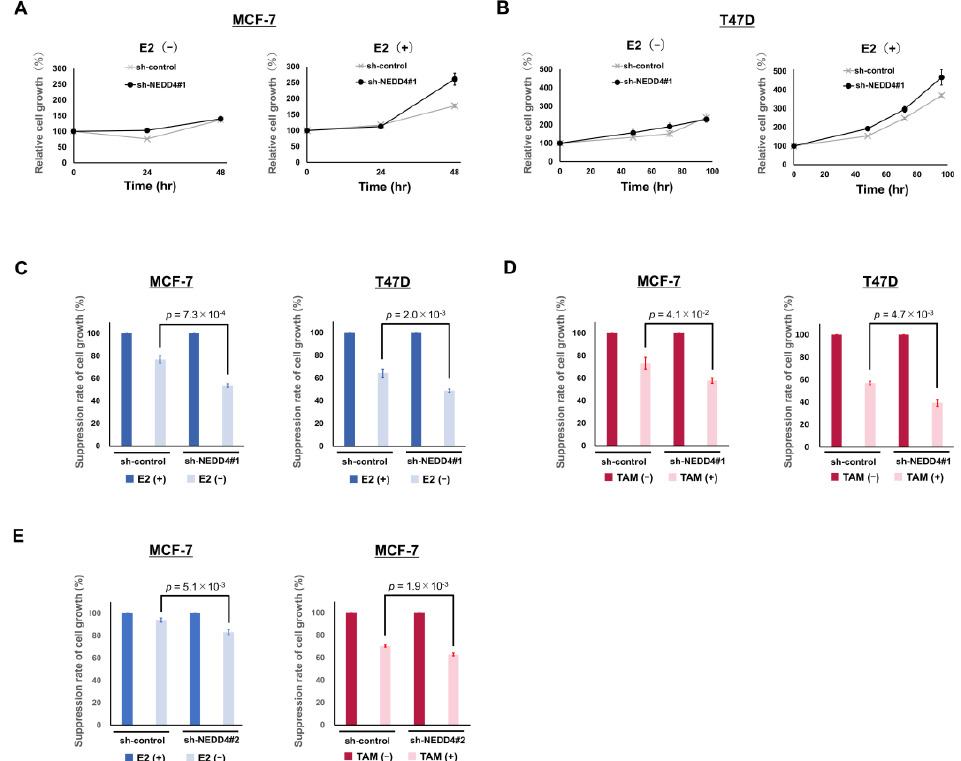
Figure 4. NEDD4 knockdown enhanced E2-dependent cell proliferation and sensitivity to TAM. Cell proliferation was measured using the Cell Counting Kit 8. ( A , B ) Comparison of the proliferation of the sh-control and sh-NEDD4#1 cells with or without E2 stimulation. The sh-NEDD4#1 cells of both MCF −7 and T47D cell lines with 1 nM E2 stimulation showed the most rapid cell growth. ( C ) Simulation of the treatment effect on the depletion of E2. In the absence of 1 nM E2, the suppression rate of the MCF7 sh-NEDD4#1 cell growth at 48 h was 53.6% compared with 76.9% for sh-control cell growth. In the T47D cell line, the suppression rate at 96 h was 49.0% (sh-NEDD4#1 cells) compared with 64.4% (sh-control cells). ( D ) Growth of the sh-control and sh-NEDD4#1 cells exposed to 2 µ M TAM + 1 nM E2. The suppression rate of the MCF7 sh-NEDD4#1 cell growth with TAM at 72 h was 57.9% compared with 73.3% for sh-control cell growth. In the T47D cell line, the suppression rate at 96 h was 39.4% (sh-NEDD4#1 cells) compared with 57.0% (sh-control cells). ( E ) NEDD4 was knocked down with another shRNA, sh-NEDD4#2. E2 absence or TAM exposure suppressed the cell growth of sh-NEDD4#2 MCF − 7 cells more than that of sh-control MCF − 7